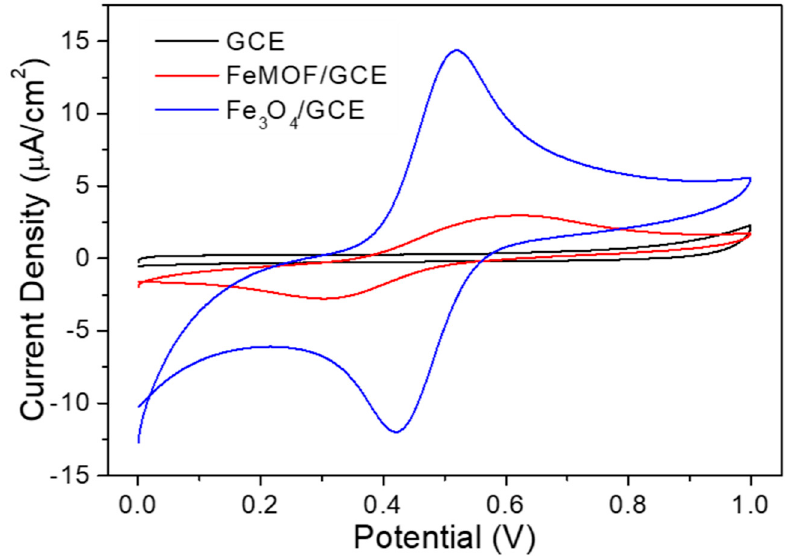
Figure 6. Cyclic Voltamogram (CV) spectra of bare GCE, FeBDC/GCE. Fe 3 O 4 /GCE in 3 mM of glucose and Phosphate Buffer Saline (PBS) of 0.1 M pH 7.4.